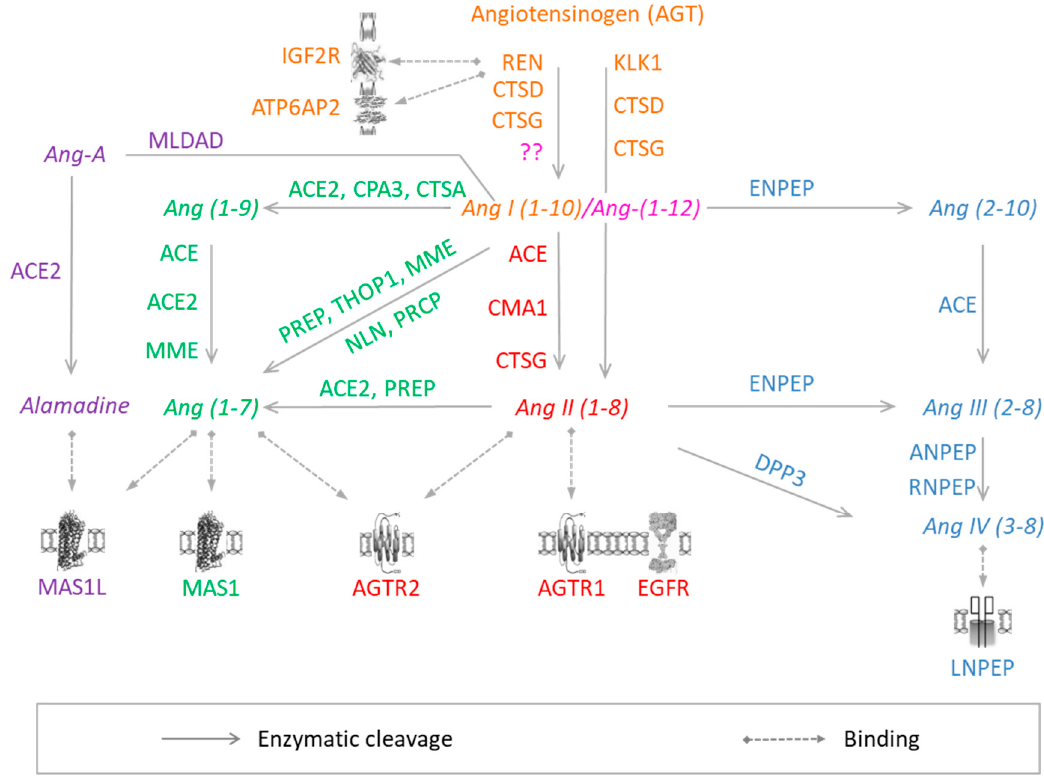
Figure 1. RAS components. Colors correspond to different arms of RAS: Orange, Angiotensin-I; pink, Angiotensin-(1–12); red, Angiotensin-II; green, Angiotensin-(1–7); Blue, Angiotensin III/VI; violet, Alamandine. Proteins are represented by the corresponding official gene symbols. The figure was adapted from Nehme et al. 2015 [7].